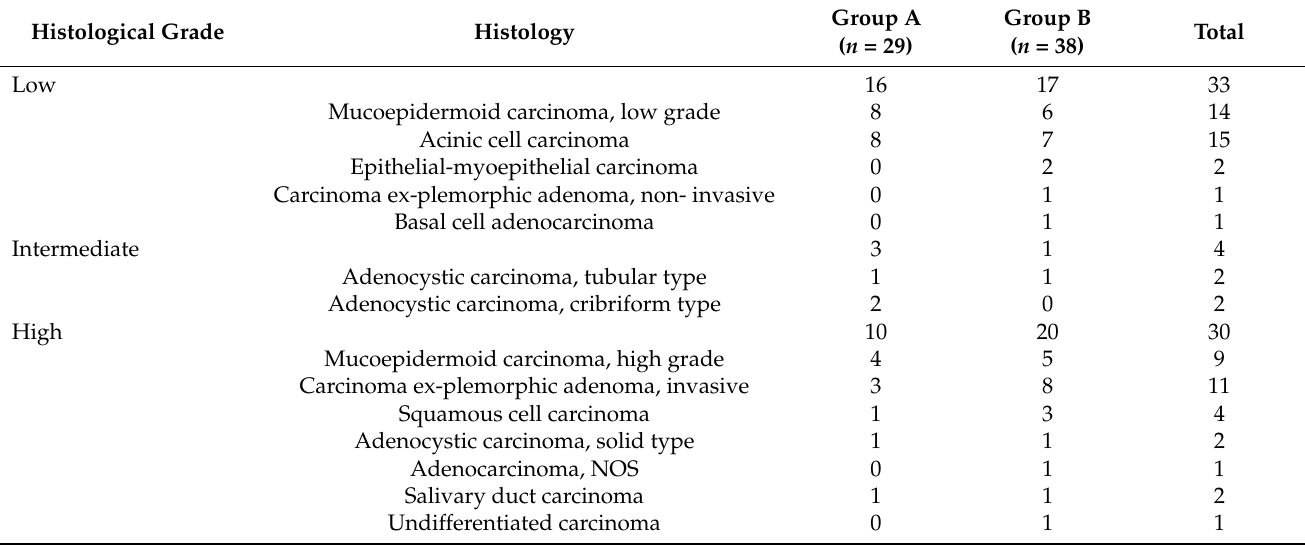
Table 2. Histological grades and